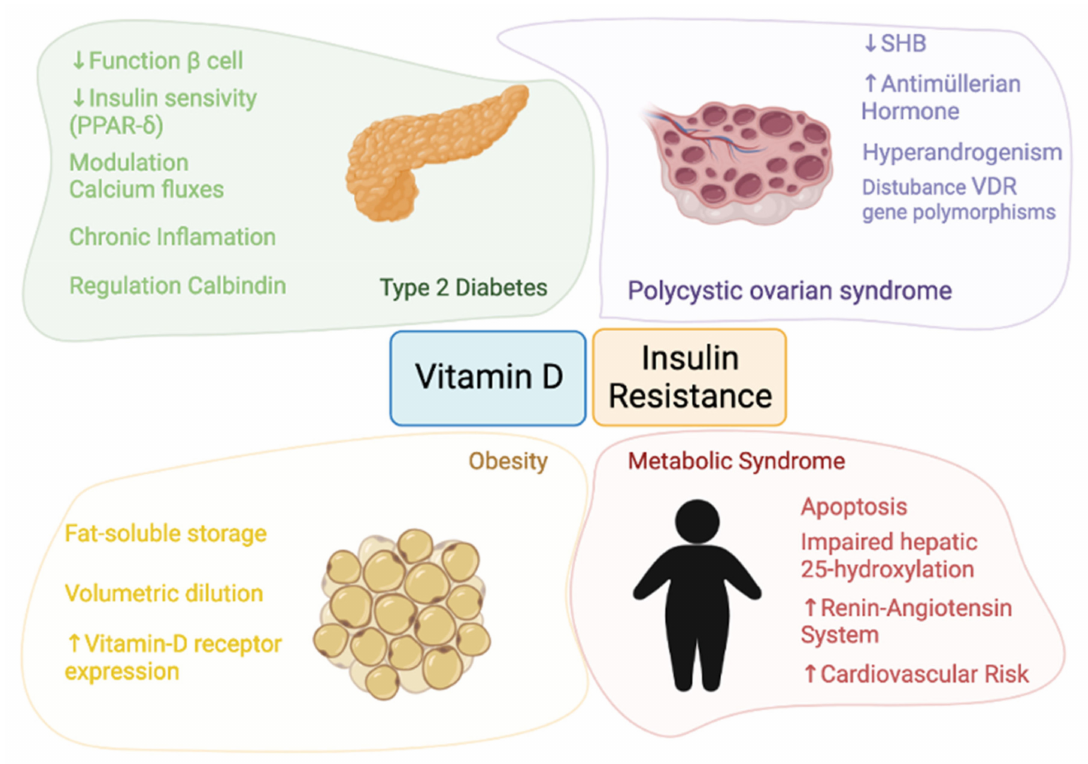
Figure 1. Pathophysiology of the relationship between vitamin D and insulin